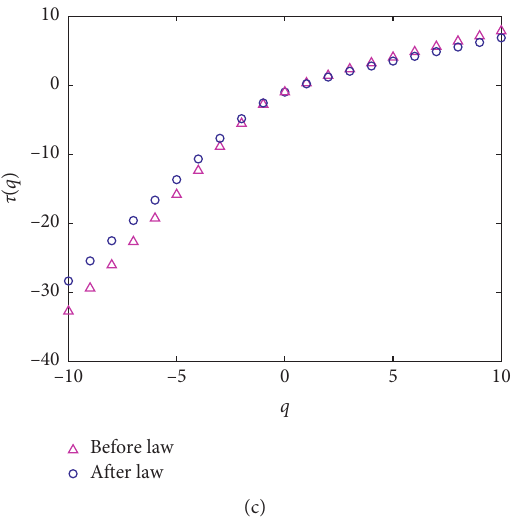
Figure 10: Renyi exponent of PM